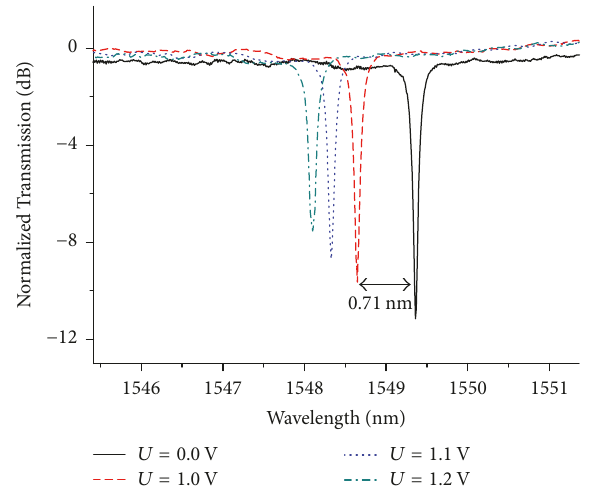
Figure 10: The static modulation of the micro-nano Si/SiGe/Si dou- ble heterojunction micro-ring electro-optic modulation.